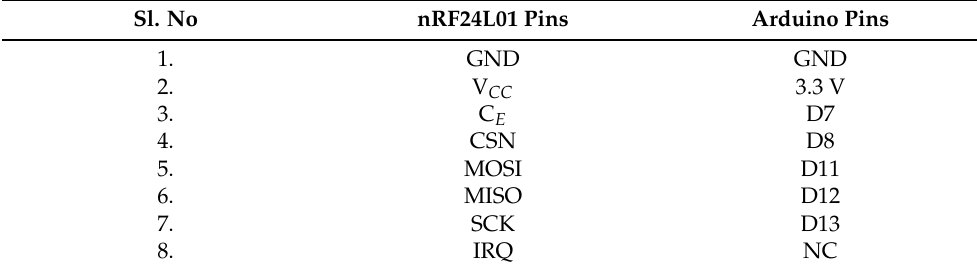
Table 1. Pin Configurations for nRF24L01 and